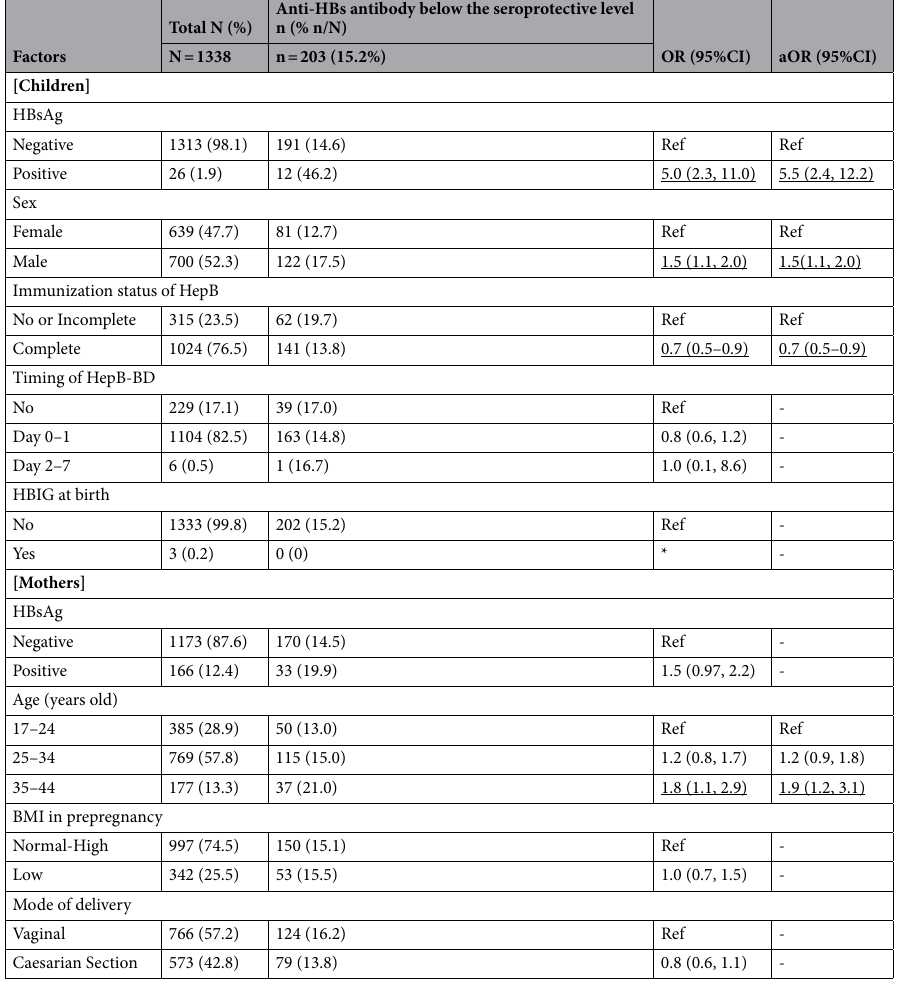
Table 4. Demographic characteristics and factors associated with anti-HBs antibody below the seroprotective level in children in the 2-year follow-up phase, Nha Trang, Vietnam, 2011–2012 (N = 1338). Logistic regression was used for projecting odds ratios (OR) in univariate analysis and adjusted odds ratios (aOR) in multivariate analysis. Variables with statistical significance were underlined where 95%CI of aOR did not include 1. HepB: hepatitis B vaccine; HBsAg: hepatitis B surface antigen; N: number; OR: odds ratio; CI: confidence interval; aOR: adjusted odds ratio; HepB-BD: birth dose of HepB; HBIG: hepatitis B immune globulin; HLA: human leukocyte antigen; BMI: body mass index; and Ref.: reference. *Dropped since no HBsAg positive cases existed in the